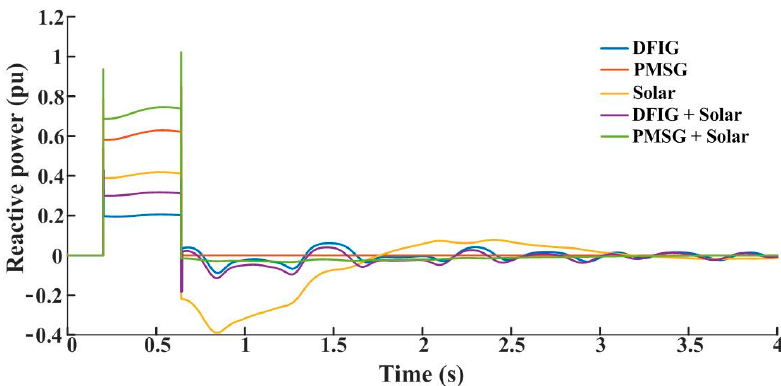
Figure 10. Reactive power support given different RES.